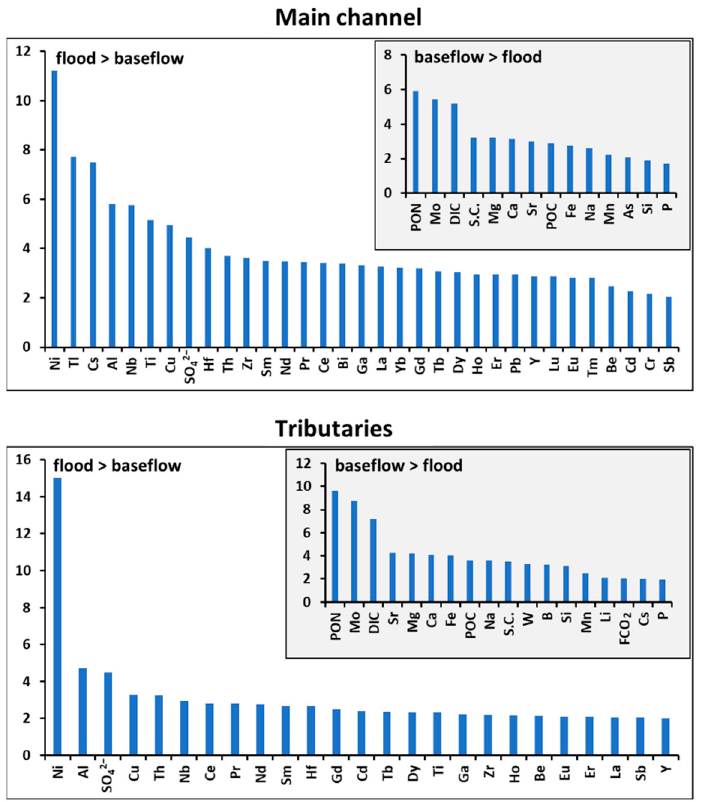
Figure 4. Mean ratio of element concentrations between spring flood period and summer baseflow in the Ket River main stem and tributaries.